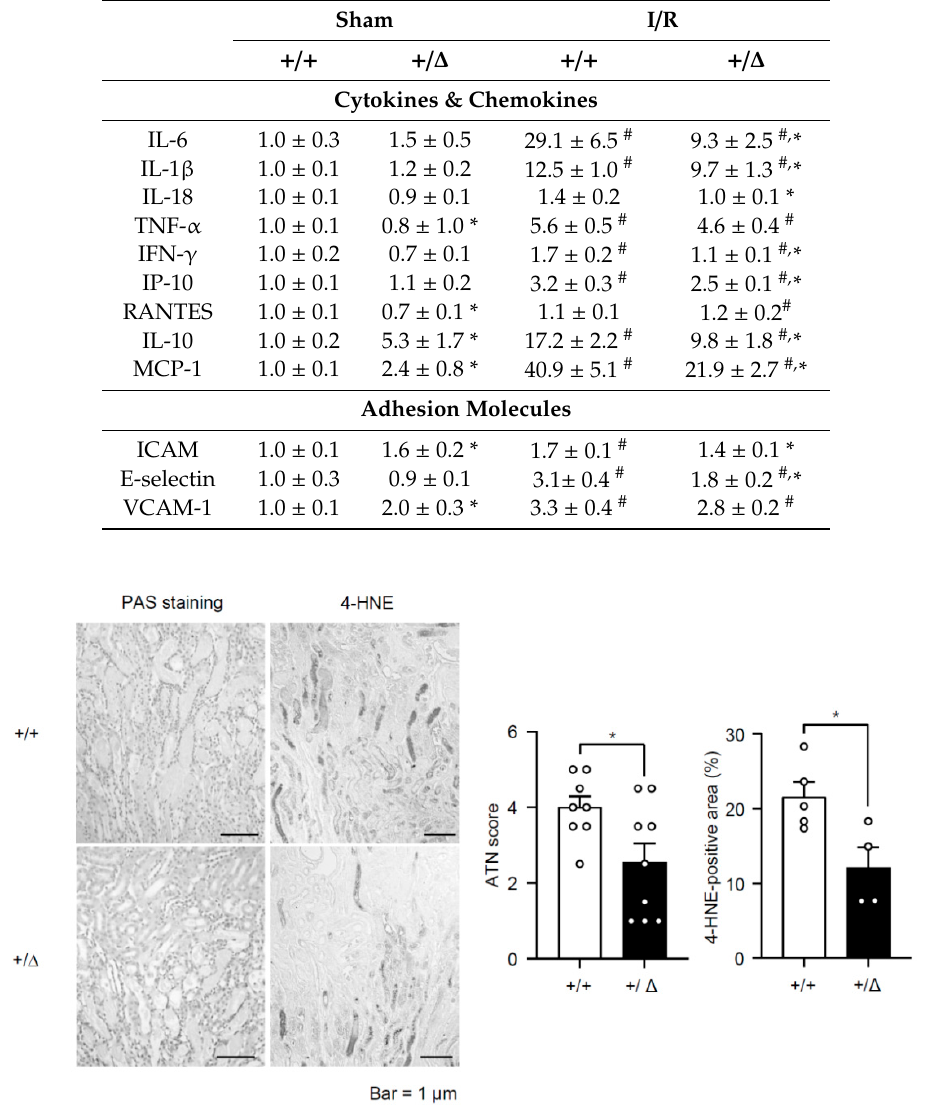
Table 1. RT-qPCR analyses of inflammatory genes and adhesion molecules in the renal outer medullae of TonEBP +/ ∆ mice ( +/ ∆ ) and their TonEBP +/+ litter mates ( +/+ ) after I / R or sham treatment of kidneys. Abundance is calculated relative to sham, +/+ . Mean ± SEM, n = 6–7. * p < 0.05 vs. corresponding +/+ . # p < 0.05 vs. corresponding sham.